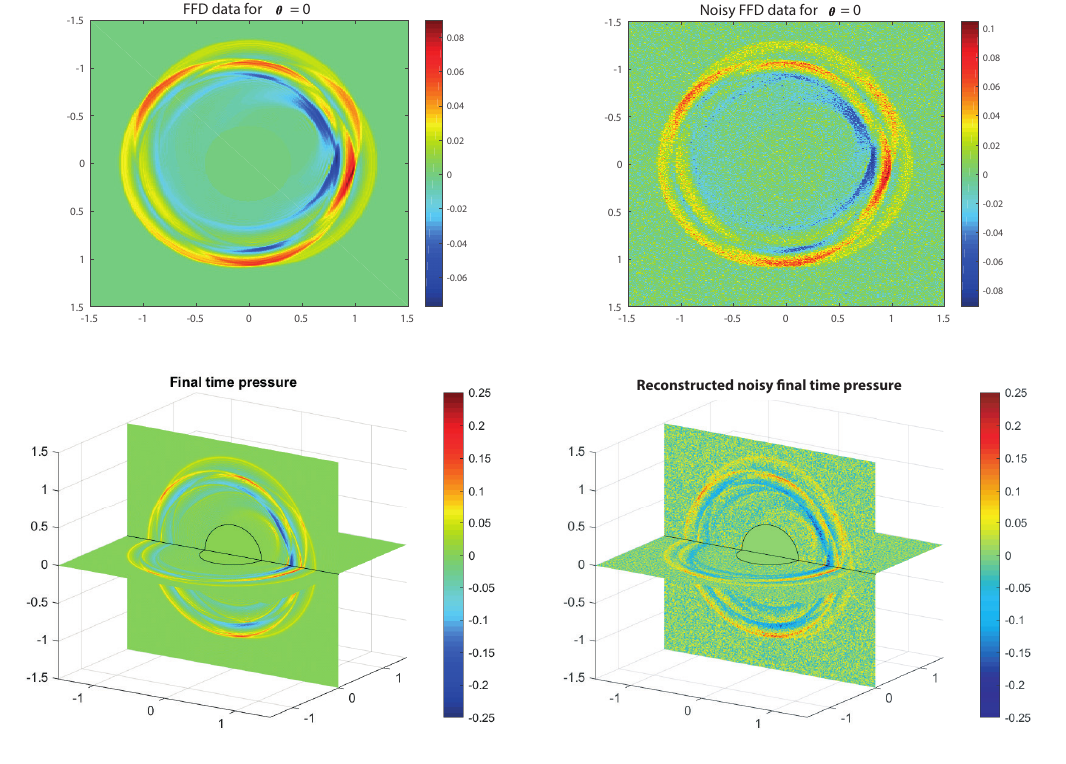
Figure 4. FFD-PAT MEASUREMENT DATA AND FINAL TIME PRESSURE . ( Top left ): Simulated FFD-PAT data g (cid:63) for projection direction θ = 0. ( Top right ): Noisy FFD-PAT data g for projection direction θ = 0. ( Bottom left ): Simulated final time pressure h (cid:63) = W f (cid:63) . ( Bottom right ): Recovered final time pressure X (cid:93) g (cid:39) h (cid:63) from noisy FFD-PAT